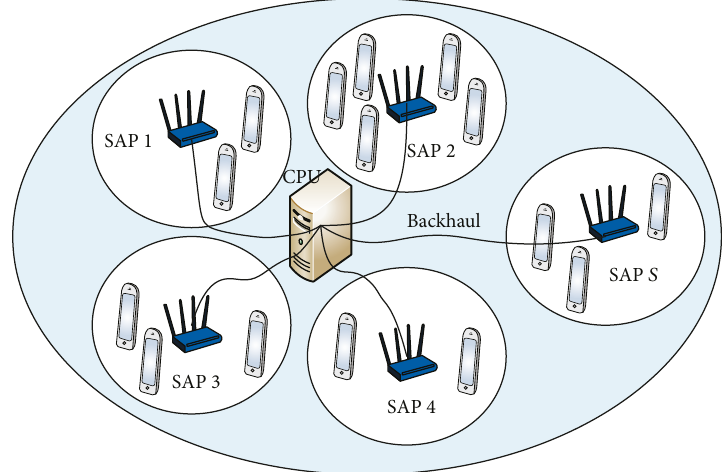
Figure 1: The system model of